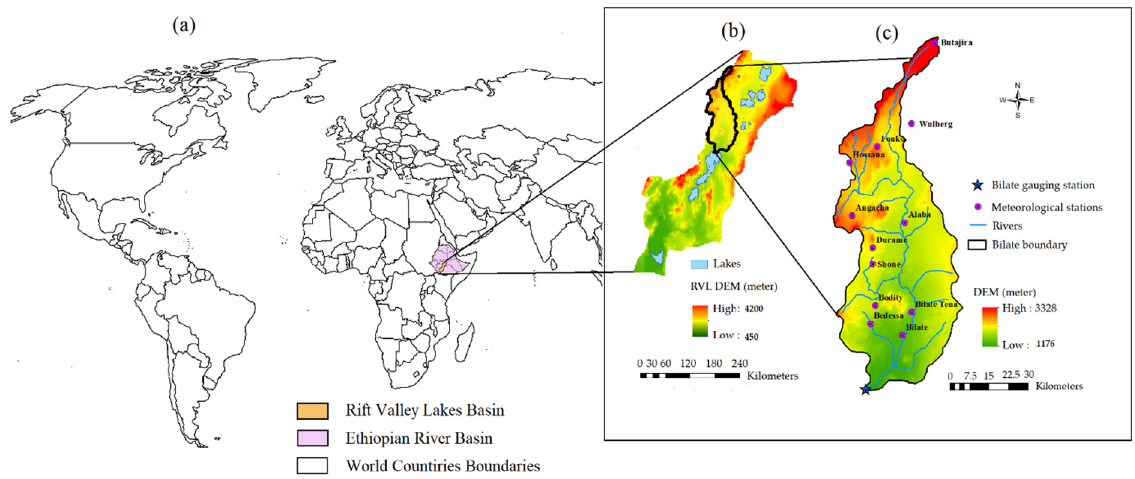
Figure 1. Map of the study area: ( a ) world map; ( b ) RVLB; ( c ) DEM and meteorological stations in the Bilate watershed.